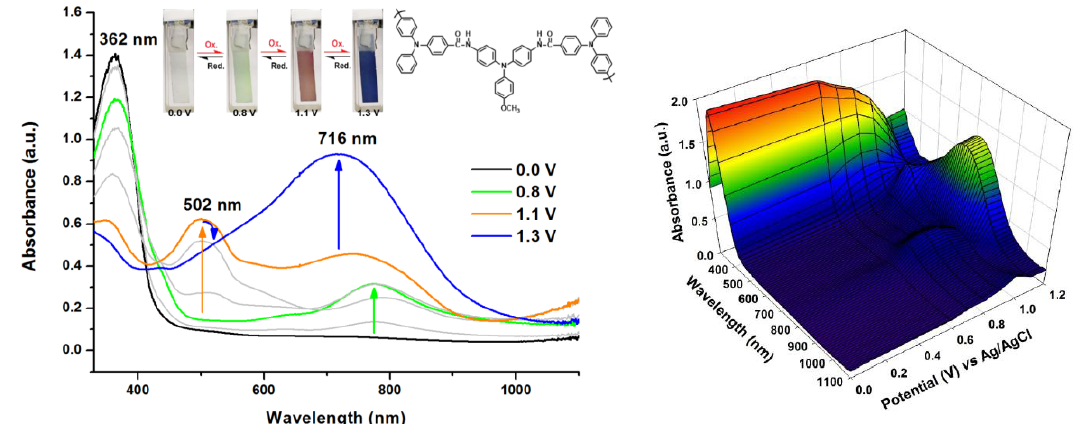
Figure 9. Spectroelectrochemistry of the electro-generated films of P1 (thickness: 250 ± 100 nm) on the ITO-coated glass substrate in 0.1 M Bu 4 NClO 4 /CH 2 Cl 2 at various applied potentials.